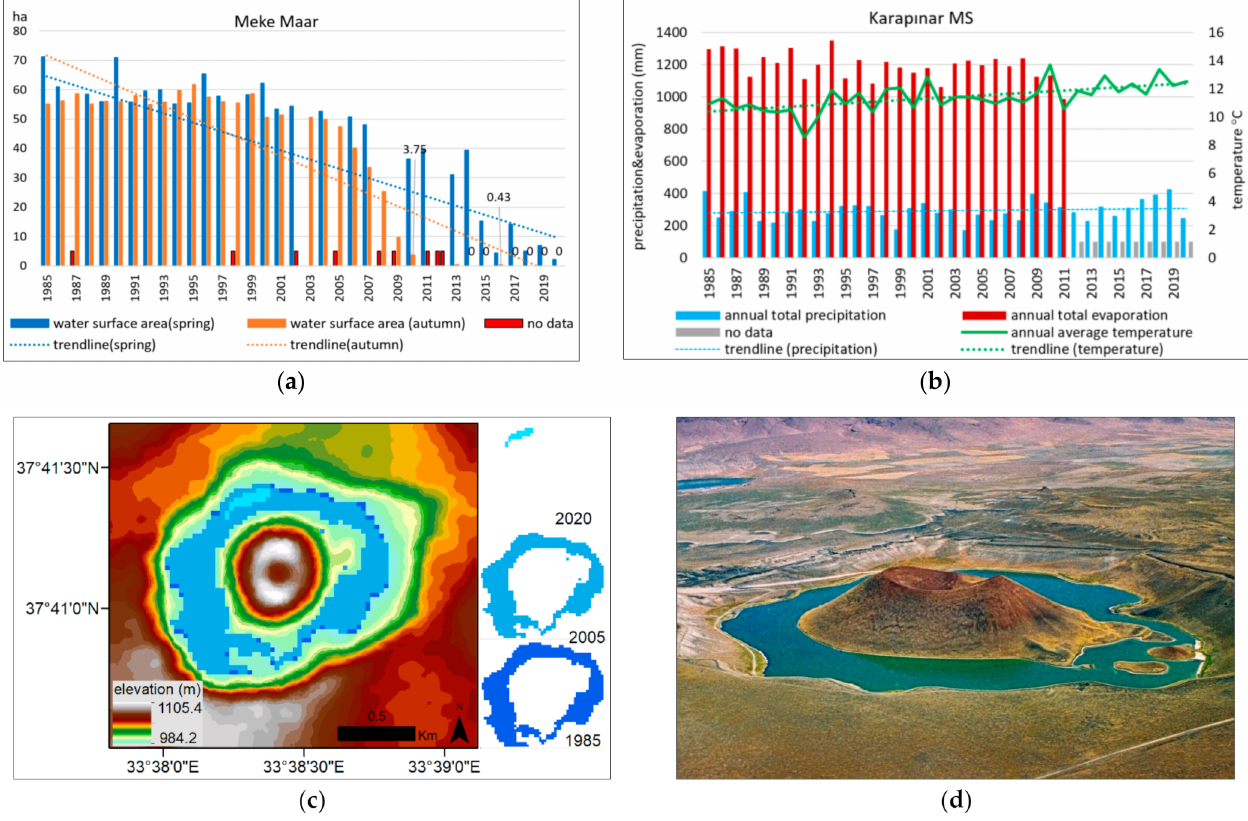
Figure 5. Meke Maar: ( a ) 1985 − 2020 annual (spring and autumn) surface water areas; ( b ) representative meteorological station data (precipitation, evaporation, and temperature); ( c ) water surface area change in spring (NDWI); ( d ) view of the maar